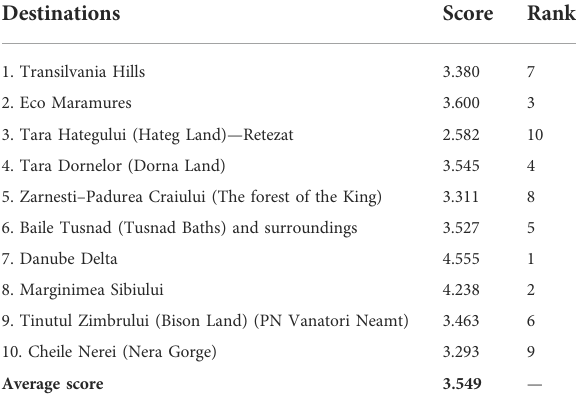
TABLE 7 Scores for the most known ecotourism destinations in